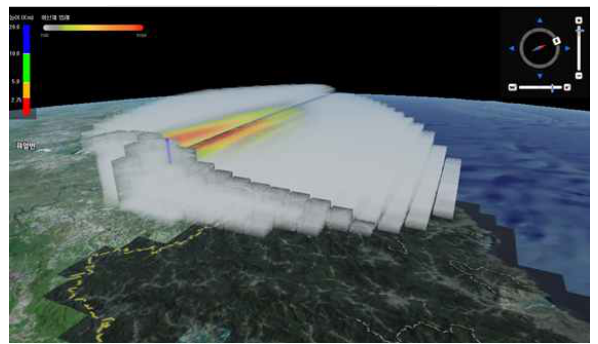
Figure 3. Mt. Baekdu area digital elevation model draped with satellite image-2